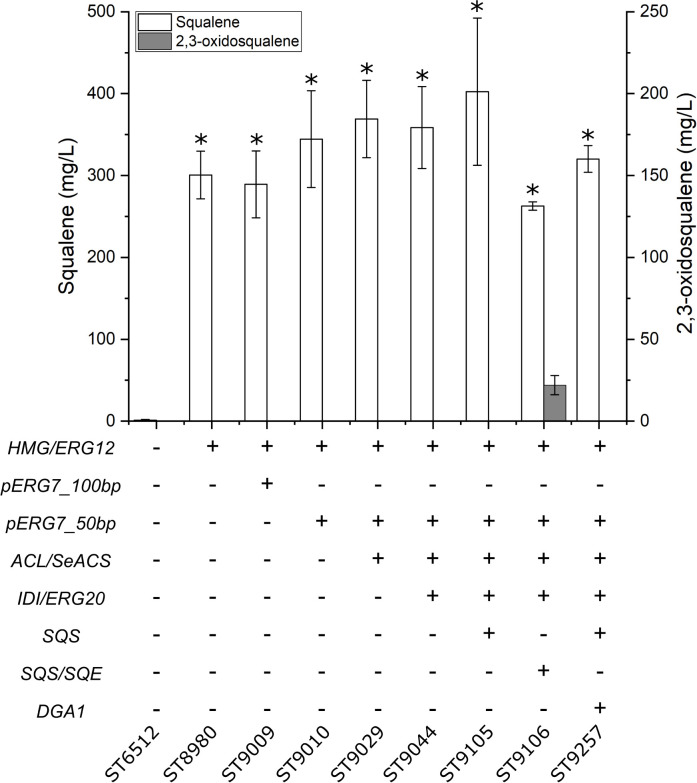
Squalene and 2,3-oxidosqualene production by the triterpene platform strain. HMG, HMG-reductase; ERG12, mevalonate kinase; pERG7_100bp and pERG7_50bp, truncation of the native lanosterol synthase promoter to 100 or 50 bp, respectively, immediately upstream of the ERG7-gene; ACL, ATP citrate lyase 1; SeACS, S. enterica acetyl-CoA synthetase; IDI, isopentyl diphosphate isomerase; ERG20, farnesyl diphosphate synthase; SQS, squalene synthase; SQE, squalene epoxidase; DGA1, diacylglycerol O-acyltransferase 1. Standard deviations from the values of three biological replicates are represented by error bars. Asterisk marks statistical significant changes compared to ST6512 (student’s t-test, two-tailed, p < 0.05).